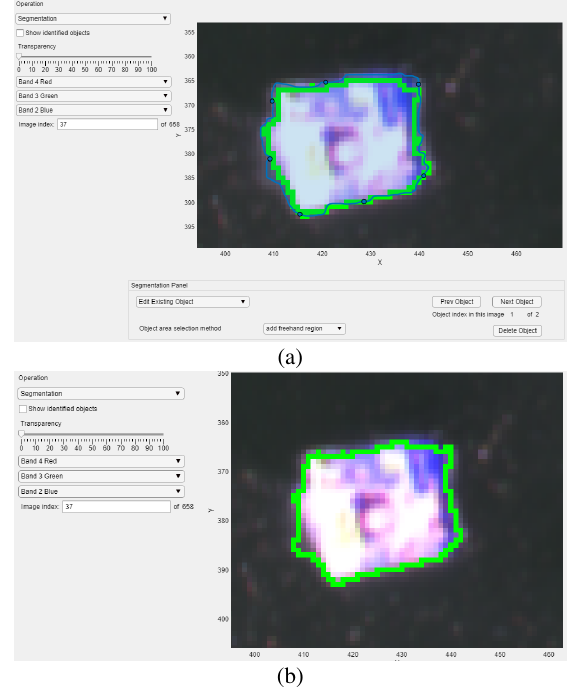
Figure 12. (a) Example of freehand area object selection tool, and of the result